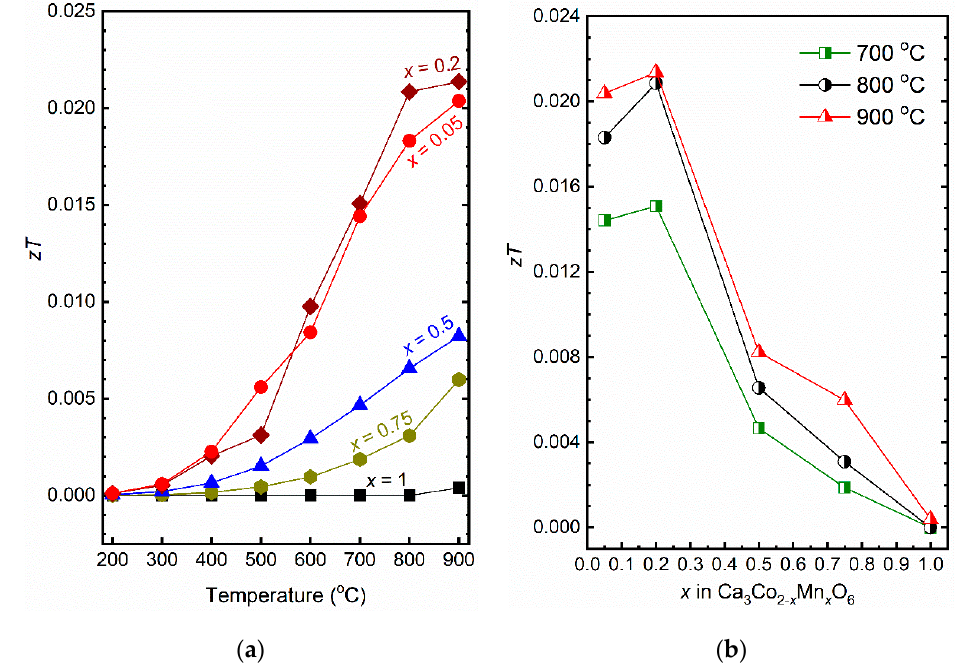
Figure 6. ( a ) Figure of merit zT of Ca 3 Co 2 − x Mn x O 6 , x = 0.05, 0.2, 0.5, 0.75, and 1 as a function of temperature and ( b ) as a function of x in Ca 3 Co 2 − x Mn x O 6 at 700, 800 and 900 °C.